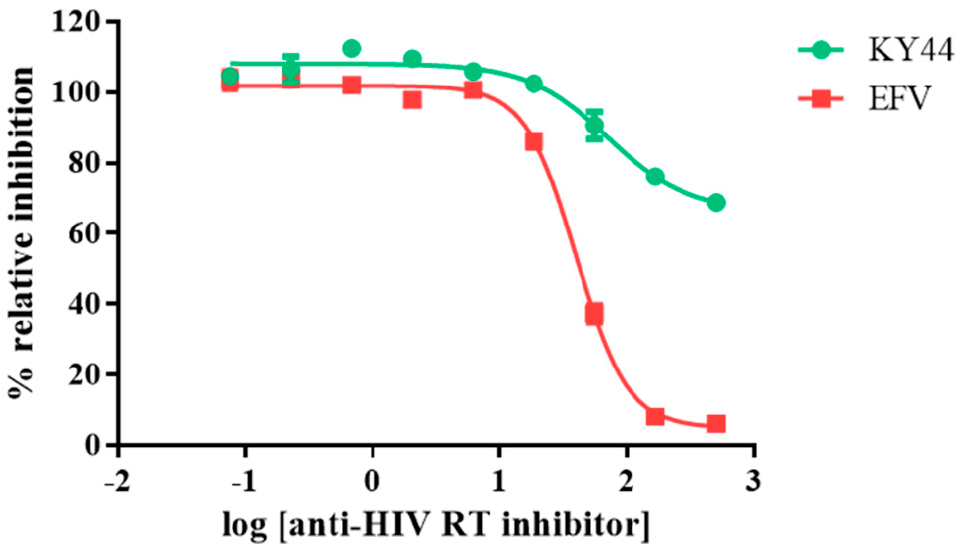
Figure 5. Cytotoxicity testing of HIV inhibitors on HEK293 cells survival. The green line represents KY44 and the red line represents EFV. Y axis showed the % relative inhibition to untreated cells. X axis showed log concentration of HIV-1 RTs inhibitors. At the high concentration, EFV and KY44 were toxic to HEK293 cells at around 100 and 20% relative inhibition, respectively. Data are represented as the mean ± SD ( n = 3).